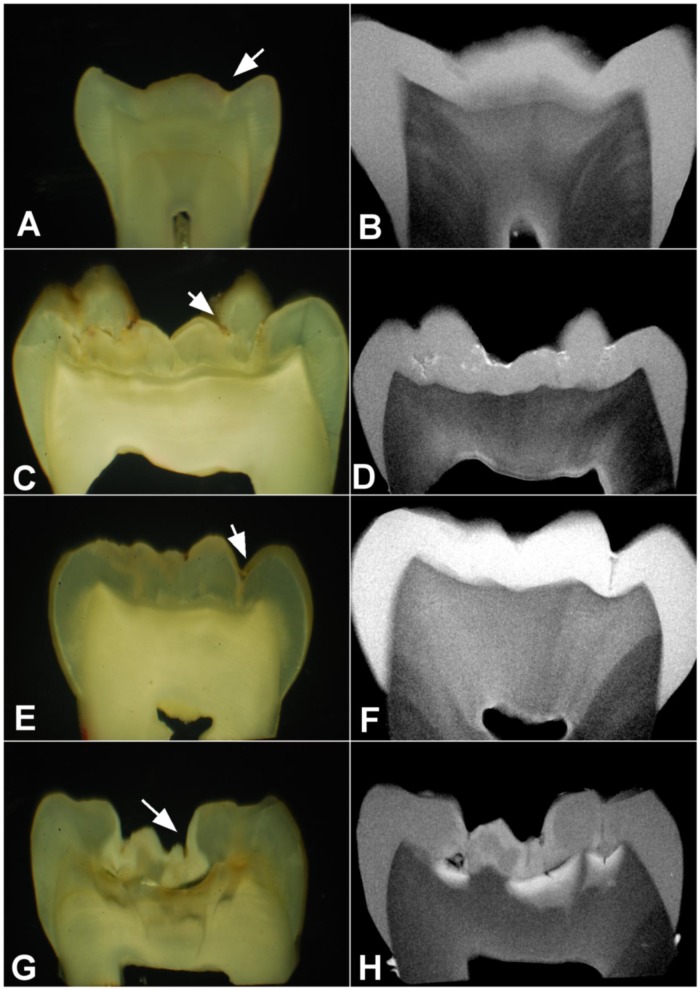
Disagreements between SM and MRC.Histological lesion depths under SM and MRC images of grounds sections of occlusal surfaces with different ICDAS scores (arrow indicates the location of ICDAS on occlusal surface): ICDAS score 0 with histological score 0 under SM (A) and histological score 4 under MRC (B); ICDAS score 1 with histological score 2 under SM (C) and histological score 4 under MRC (D); ICDAS score 2 with histological score 2 under SM (E) and histological score 4 under MRC (F); and ICDAS score 3 with histological score 2 under SM (G) and histological score 4 under MRC (H).